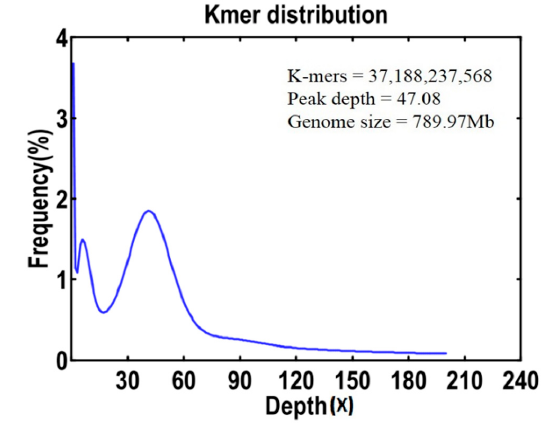
Figure 1. The distribution of K-mer ( K = 19) analysis based on the whole genome shotgun data in Luffa cylindrica L. (The peak K-mer frequency was 47.08. Genome size was estimated with the formula: estimated genome size = K-mer count/Peak of the depth distribution). Int. J. Mol. Sci. 2017 , 18 , 1942